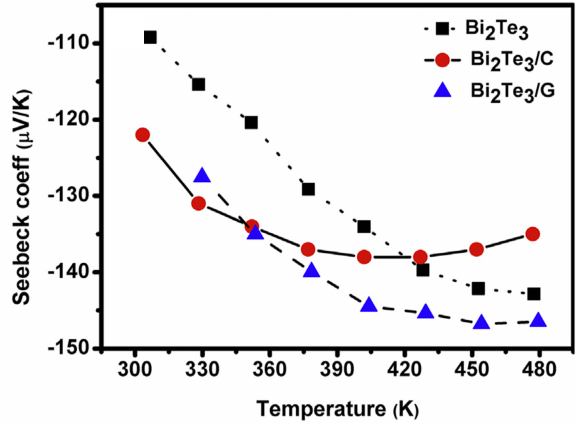
Figure 14: Temperature dependence of the Seebeck coeflcient of bulk Bi 2 Te 3 and Bi 2 Te 3 composite. The addition of graphene leads to an increase in the Seebeck coeflcient. Reproduced from Ref.